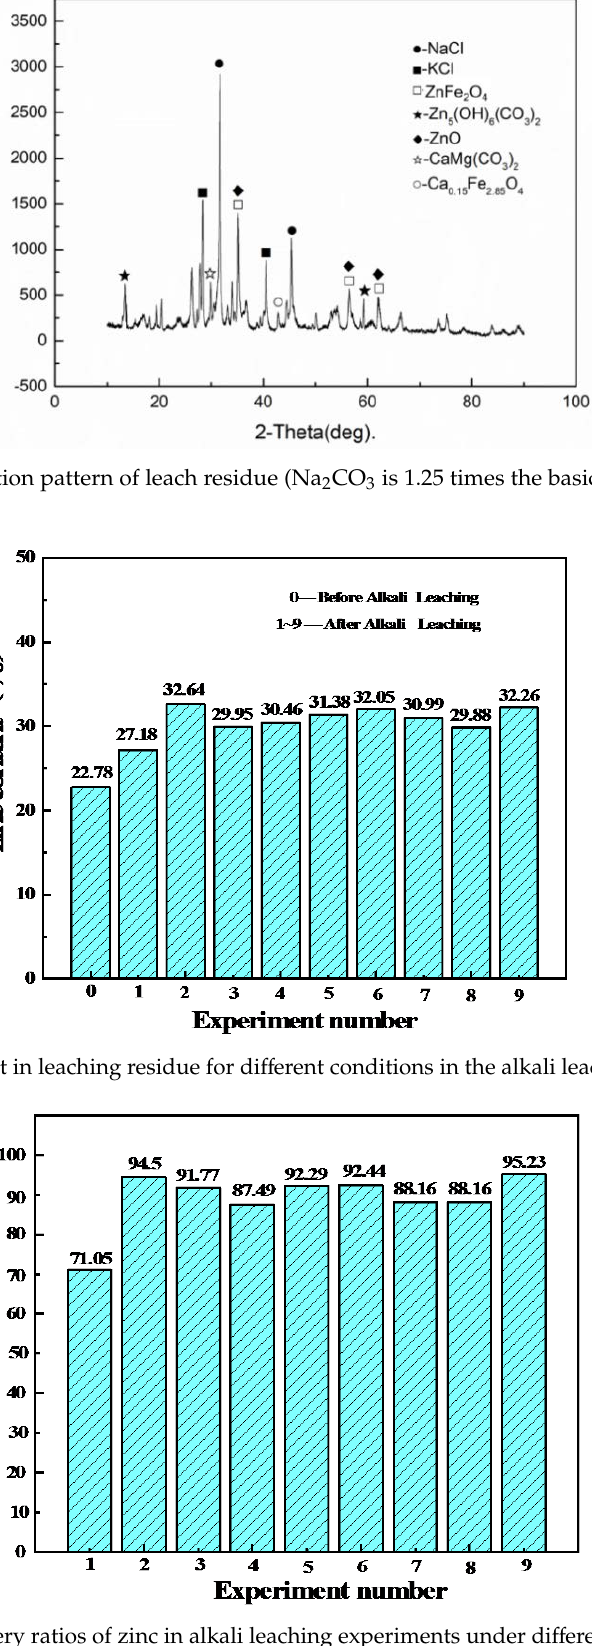
Figure 10 that under the experimental condition with a 6:1 liquid–solid ratio and 1.5 times the Na 2 CO 3 quantity, the maximum recovery ratio of zinc reached 95.23%. 3.4. Effect of the Evaporation–Crystallization Process Parameters on KCl Extraction 3.4.1. Effect of Volume Evaporation Ratio on KCl Extraction Evaporation–crystallization experiments were performed on the leaching solution obtained from the optimal alkali leaching process of the RHF secondary dust (Group 9). The experimental results for different volume evaporation ratios are listed in Table 8. Under the process conditions of evaporation temperature of 80 °C and cooling temperature of 15 °C, the volume of evaporation changed to obtain KCl crystals of different masses. According to the potassium element content in the leaching solution in Table 7 and Equations (6) and (7), the crystallization ratios of potassium and the mass fraction of K 2 O were calculated. Table 8. Experimental results under different volume evaporation ratios. Volume– Evaporation Ratio (%)